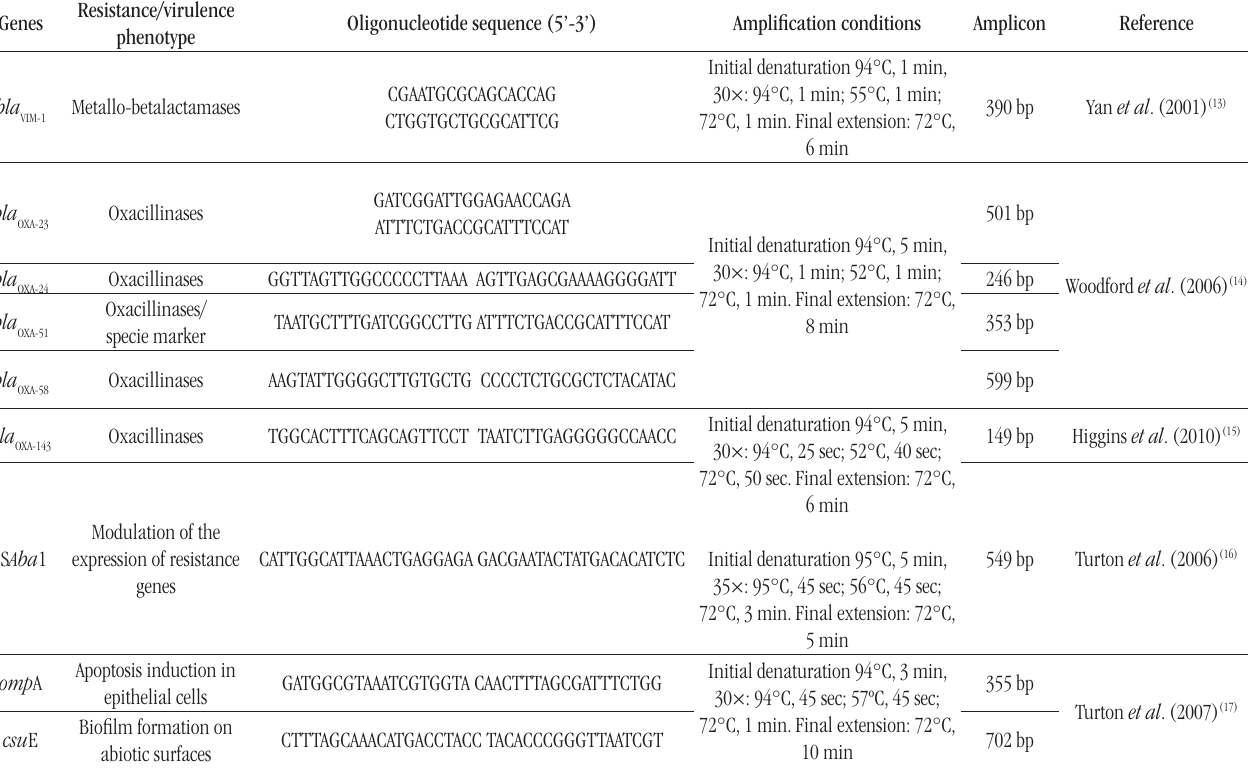
taBLE 1 − Oligonucleotides, amplicons and PCR reaction conditions used in genetic determinants of antimicrobial resistance and virulence